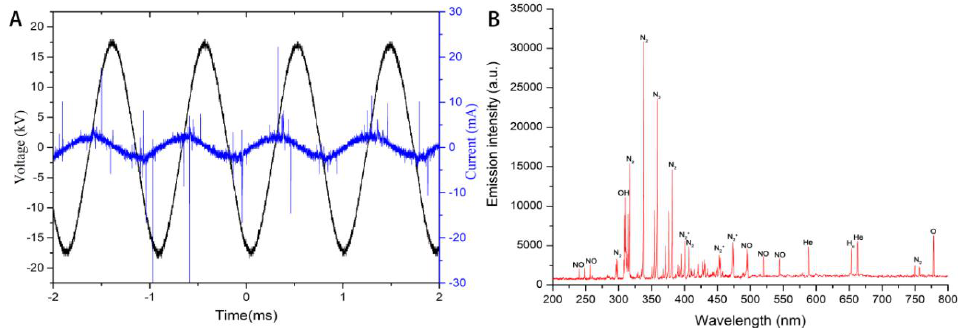
Figure 2. The waveforms of applied voltage and current ( A ) and the optical emissions spectra (OES) of the CJAP plasma jet ( B ).